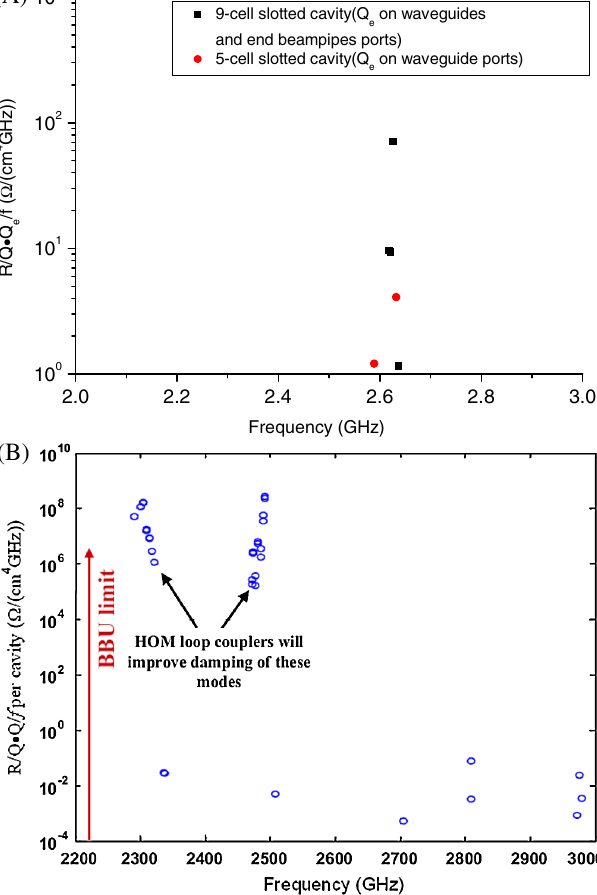
FIG. 12. (Color) A comparison of the dipole modes of three different cavities: (A) The slotted cavities; (B) KEK-ERL model-2 cavity [1]; (C) Cornell seven-cell cavity [4].